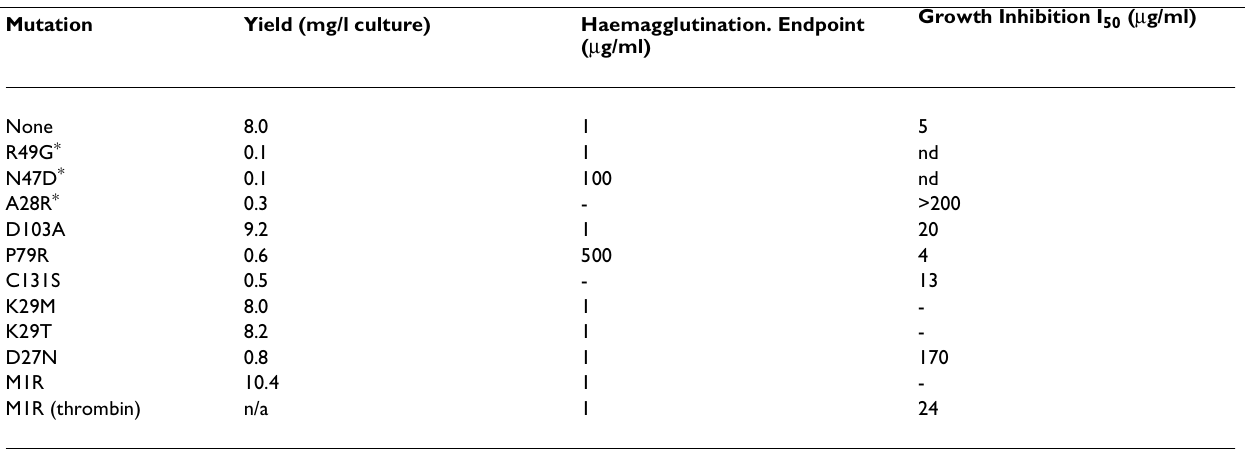
Table 1: Summary of Galectin-1 Mutations